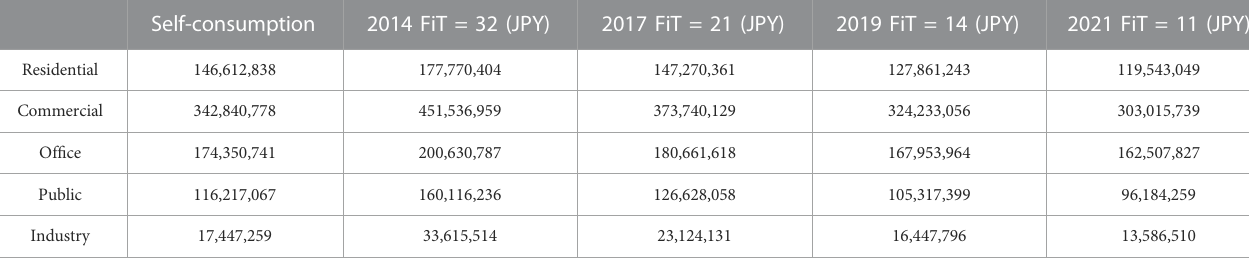
TABLE 6 Summary of the VPP annual electricity bill saving considering different FiT.